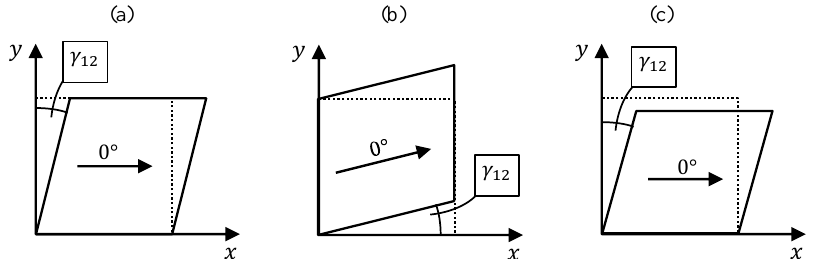
Figure 14. Simple shear load cases ( a ) and ( b ) and pure shear load case ( c ) resulting in the same shear strain γ 12 , but different ε 1 , ε 2 and ε ⊥